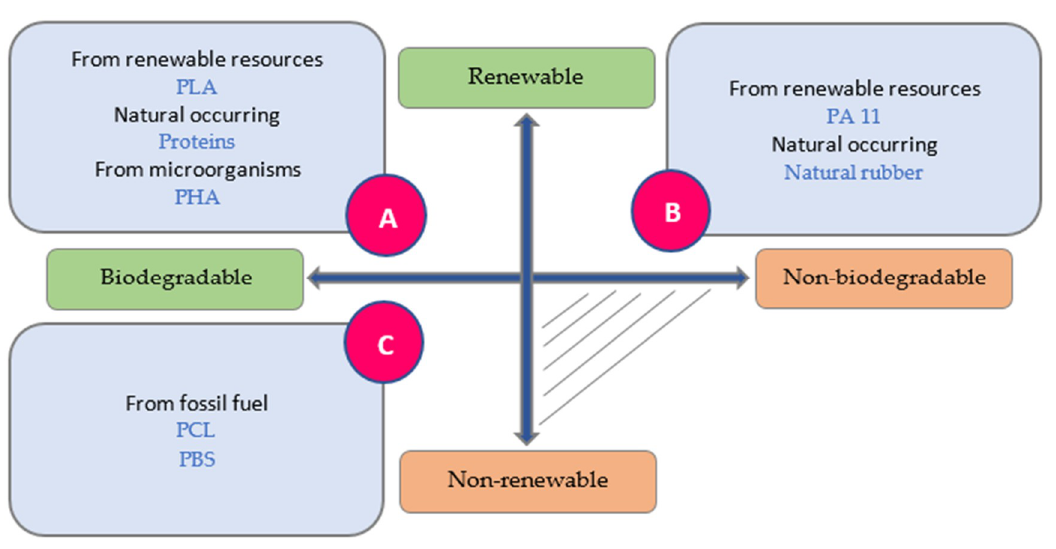
Figure 6. Biopolymer matrices classifications [ © MB, JA, MAM_UC3M2020] .